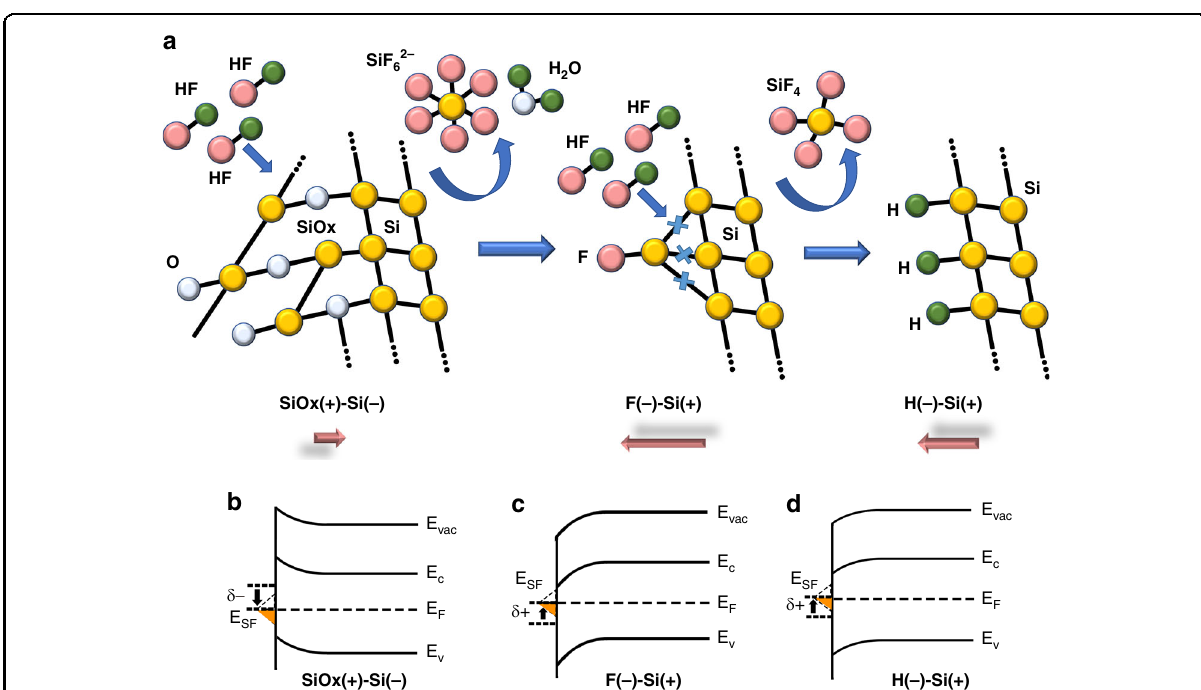
Fig. 4 The BHF etching process and band diagram variation. a Chemical process on the Si surface during BHF etching and the surface dipole moment resulting from different electronegativities of surface atoms. The native oxide layer is removed, F-terminated Si is generated as a mid-stage, and the H-terminated surface is fi nally formed as the stable condition. The effect of the surface dipoles on the band diagrams of the ( b ) n − -type Si surface with a native oxide layer, ( c ) F-terminated surface, and ( d ) H-terminated